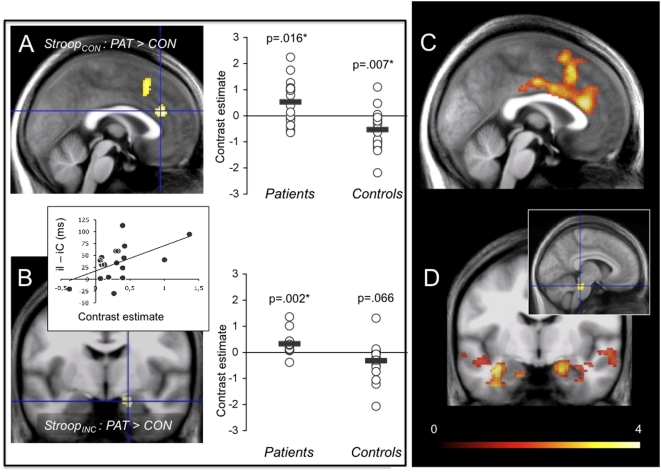
Across group comparison of response to conflict as separated by preceding trial type. (A) In response to conflict trials preceded by congruent trials (StroopCON) patients showed stronger dACC/dmPFC activation than controls. This effect was based on activation in patients and deactivation in controls (contrast estimates extracted at peak voxel x = 2, y = 30, z = 22, cluster thresholded at pvoxel<0.005). (B) In response to conflict trials preceded by incongruent trials (StroopINC) patients showed stronger right temporomesial including amygdalar activation. Extraction of contrast estimates (peak voxel within amygdala mask, x = 18, y = −8, z = −20) demonstrated that activation occured only in patients, showing a positive correlation with their behavioural interference (rho = 0.461, p = 0.013). (C) Isolation of the effect of the previous trial type revealed less dmPFC/ACC activation in patients compared with controls when switching from incongruent to congruent background. (D) In turn, patients showed more activation of the bilateral amygdala-hippocampal complex and the brainstem. The inlay shows the most robust part of the cluster locating to the upper pons and midbrain area (pvoxel<0.01, corrected pcluster = 0.034).